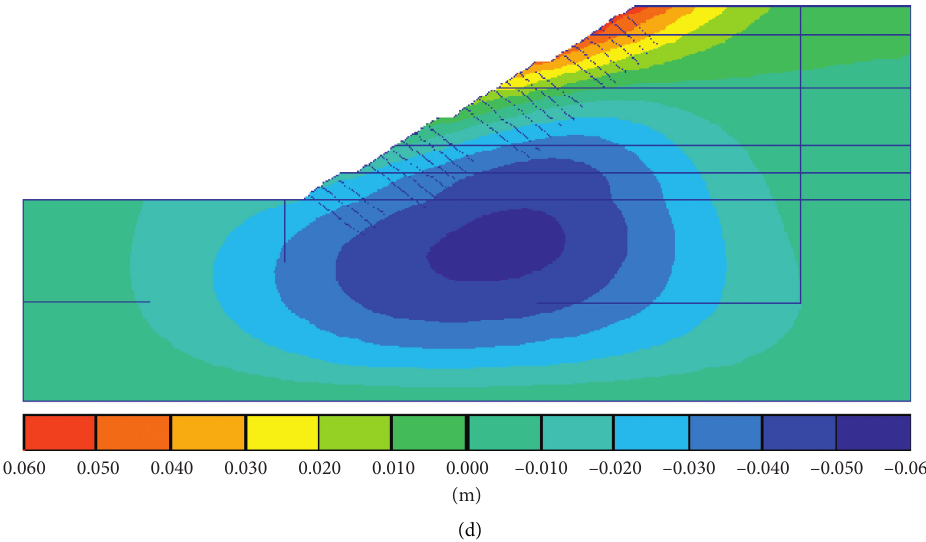
Figure 7: Horizontal displacement nephogram with the construction conditions of slope. (a) Working condition 2. (b) Working condition 4. (c) Working condition 6. (d) Working condition